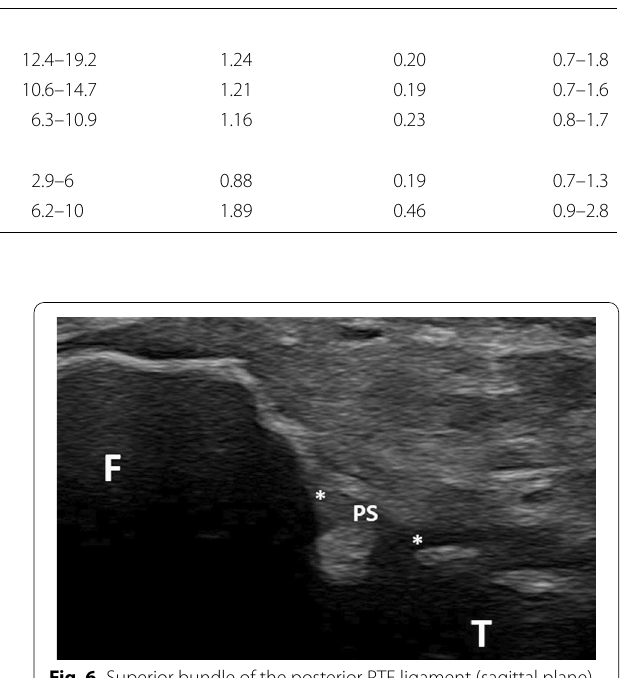
Fig. 6 Superior bundle of the posterior PTF ligament (sagittal plane). The superior bundle (PS) courses from the posterior and superior aspect of the fibular styloid (F) to the posterior aspect of the lateral condyle of the tibia (T)